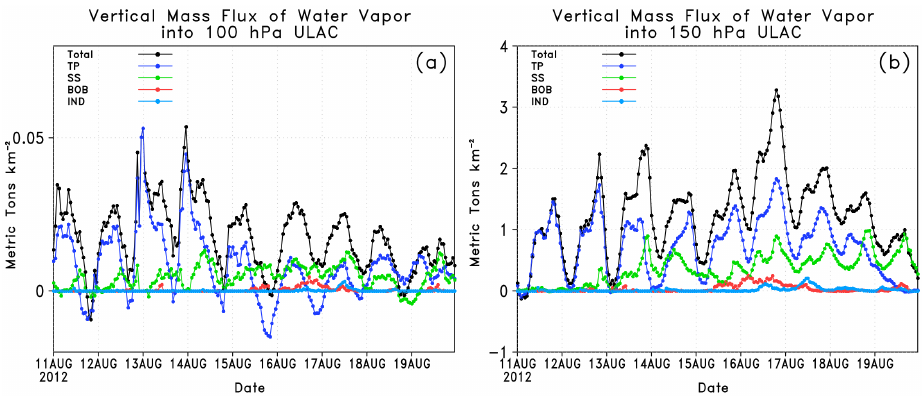
Fig. 11. Vertical water vapor mass flux (metric tonskm − 2 ) into the ULAC at 100hPa (a) and 150hPa (b) . The black line indicates the total mass flux, and the colors indicate the amount from each defined region (Fig. 7). Note the two-orders-of-magnitude change between 150 and 100hPa.